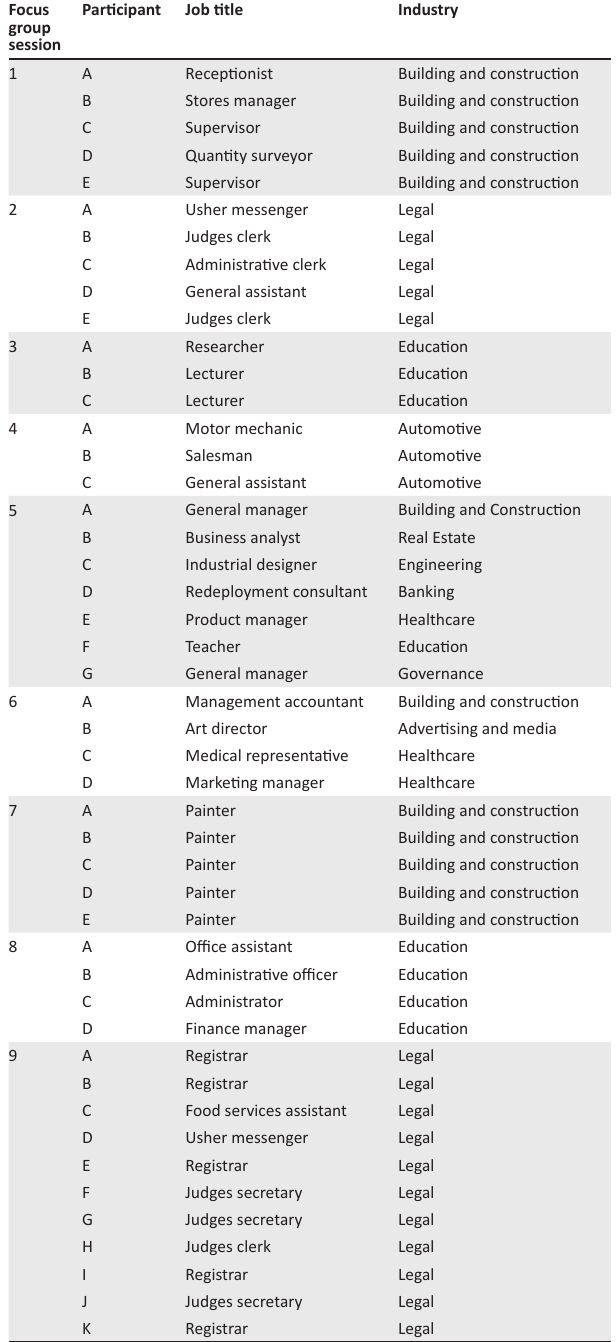
TABLE 3: Focus group participant